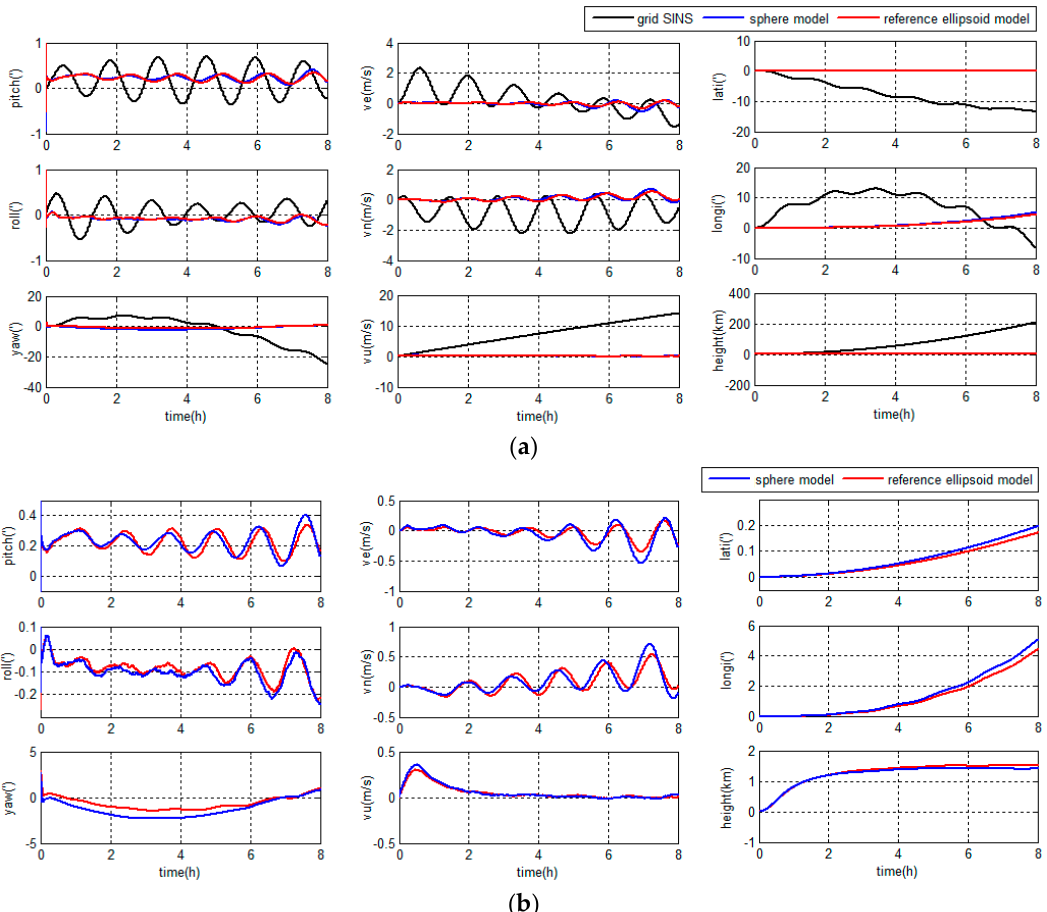
Figure 8. Navigation errors in middle latitude regions: ( a ) grid strapdown inertial navigation system (SINS) errors and integrated navigation errors; and ( b ) integrated navigation errors. The navigation errors in high latitude regions are depicted in Figure 9 and Table 2.